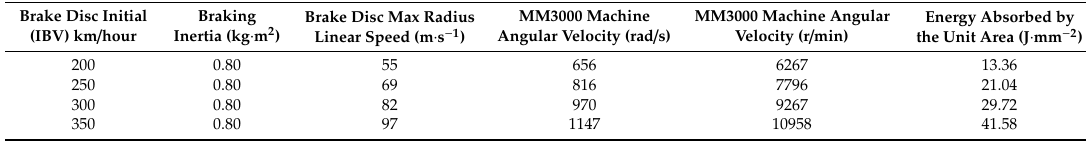
Table 3. Experimental parameters for sub-scale